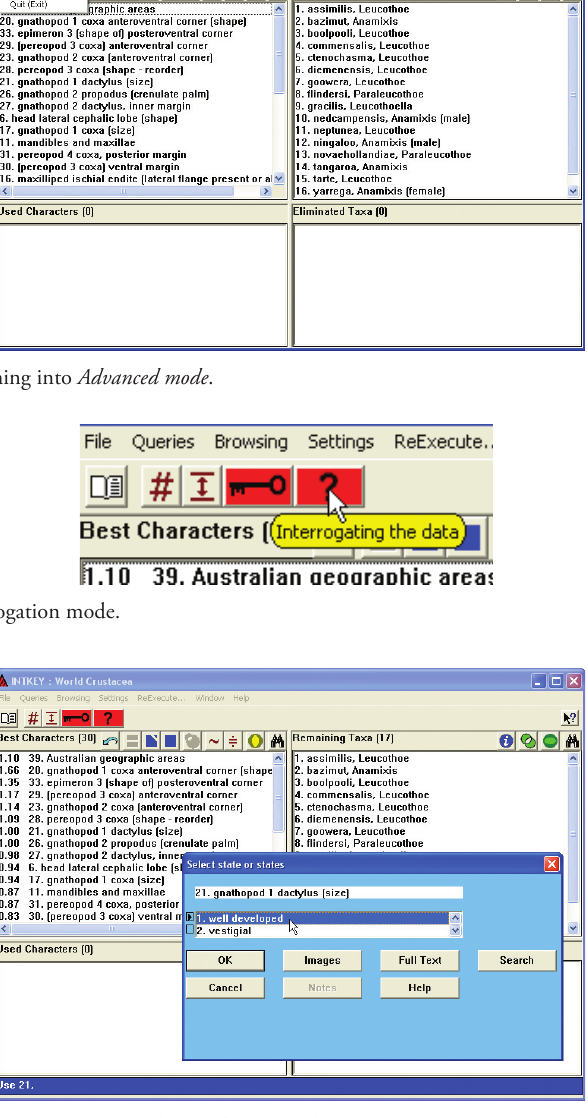
Figure 64. Character 21 is selected for the fi rst step of identifi